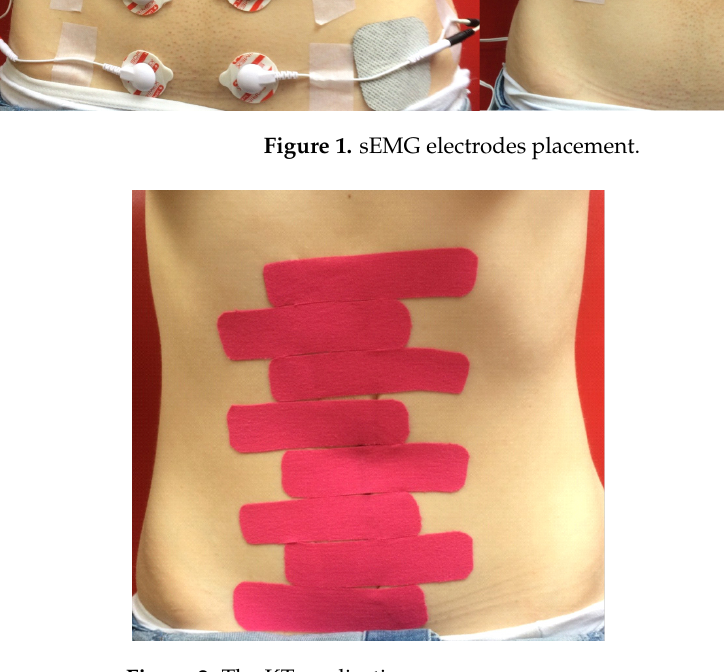
Figure 2. The KT application. Figure 2. The KT